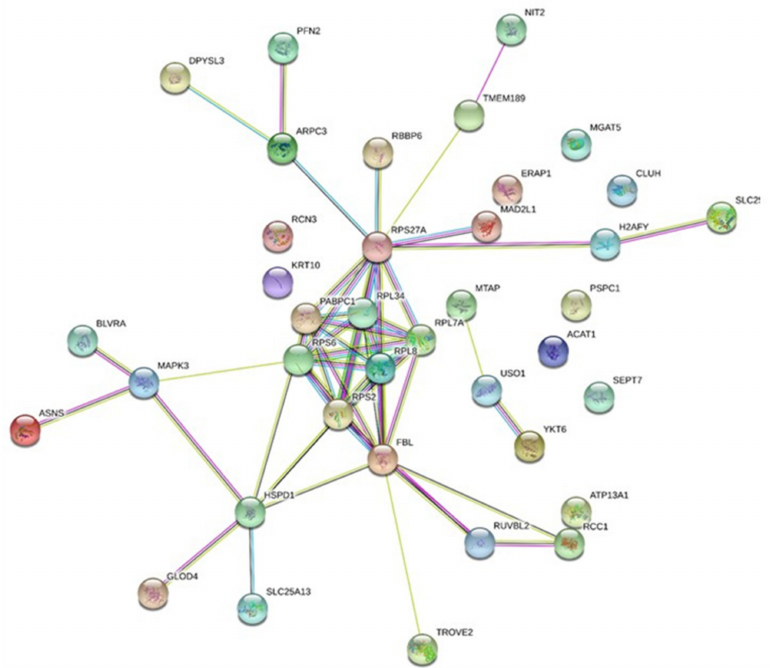
Figure 1. Bystander secretome network. Protein–protein interaction network constructed with protein accession from the list of 40 modulated proteins (24 up-regulated and 16 down-regulated) in the medium-conditioned/secretomic analysis. The network was constructed on STRING database.